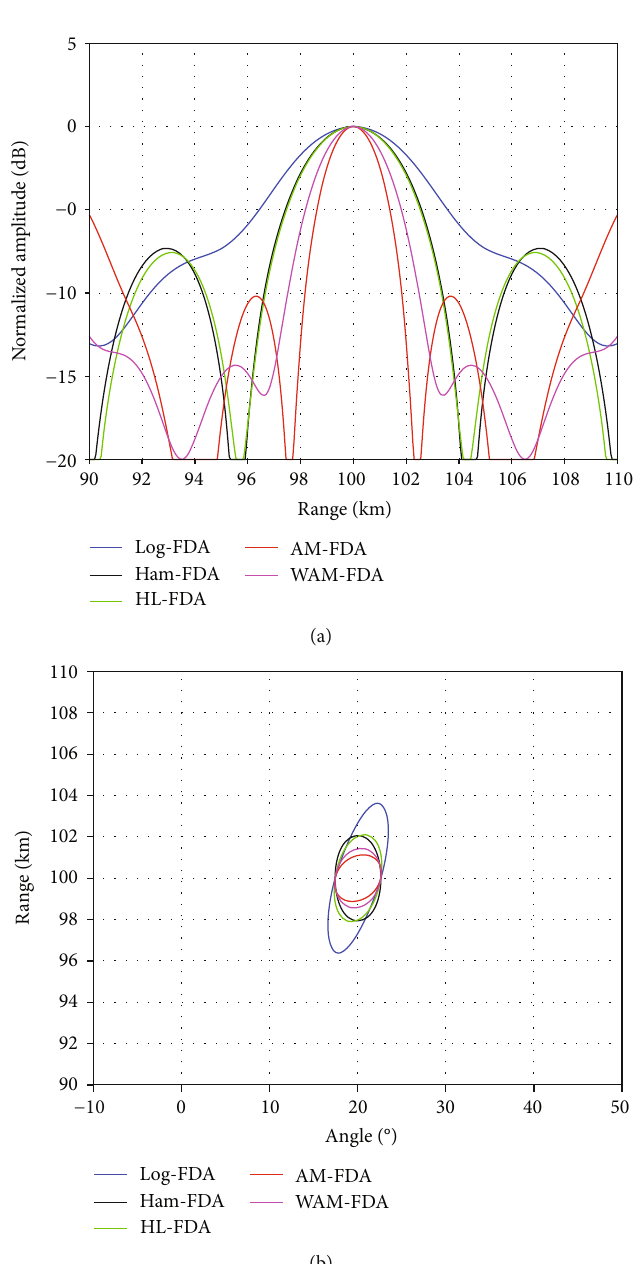
Figure 8: Comparative results of (a) the equivalent transmit beampatterns in the pro fi le of range and (b) ellipses generated by di ff erent